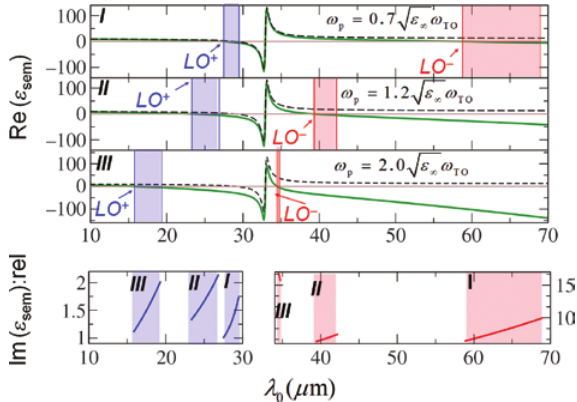
Figure 25: The LOPC effect in InP and its cost in optical loss. (Top panels) The full permittivity, ε (real part), versus the free- sem space wavelength λ , for three different plasma frequencies, ω of 0 p the free carriers is shown. The vertical blue (red) lines annotated with LO + (LO − ), depict the blue (red)-shifted LO phonon frequencies. The shaded regions highlight spectral ranges with Re( ε ) between sem −5 and 0 which is of interest for plasmonic-type effects and certain metamaterials. (Bottom panels) The imaginary part of ε is sem plotted within the shaded regions in the top panels, scaled with a reference value, Im( ε ) equal to the imaginary part of the ionic-only ref permittivity, ε at the frequency where the respective real part is ion equal to